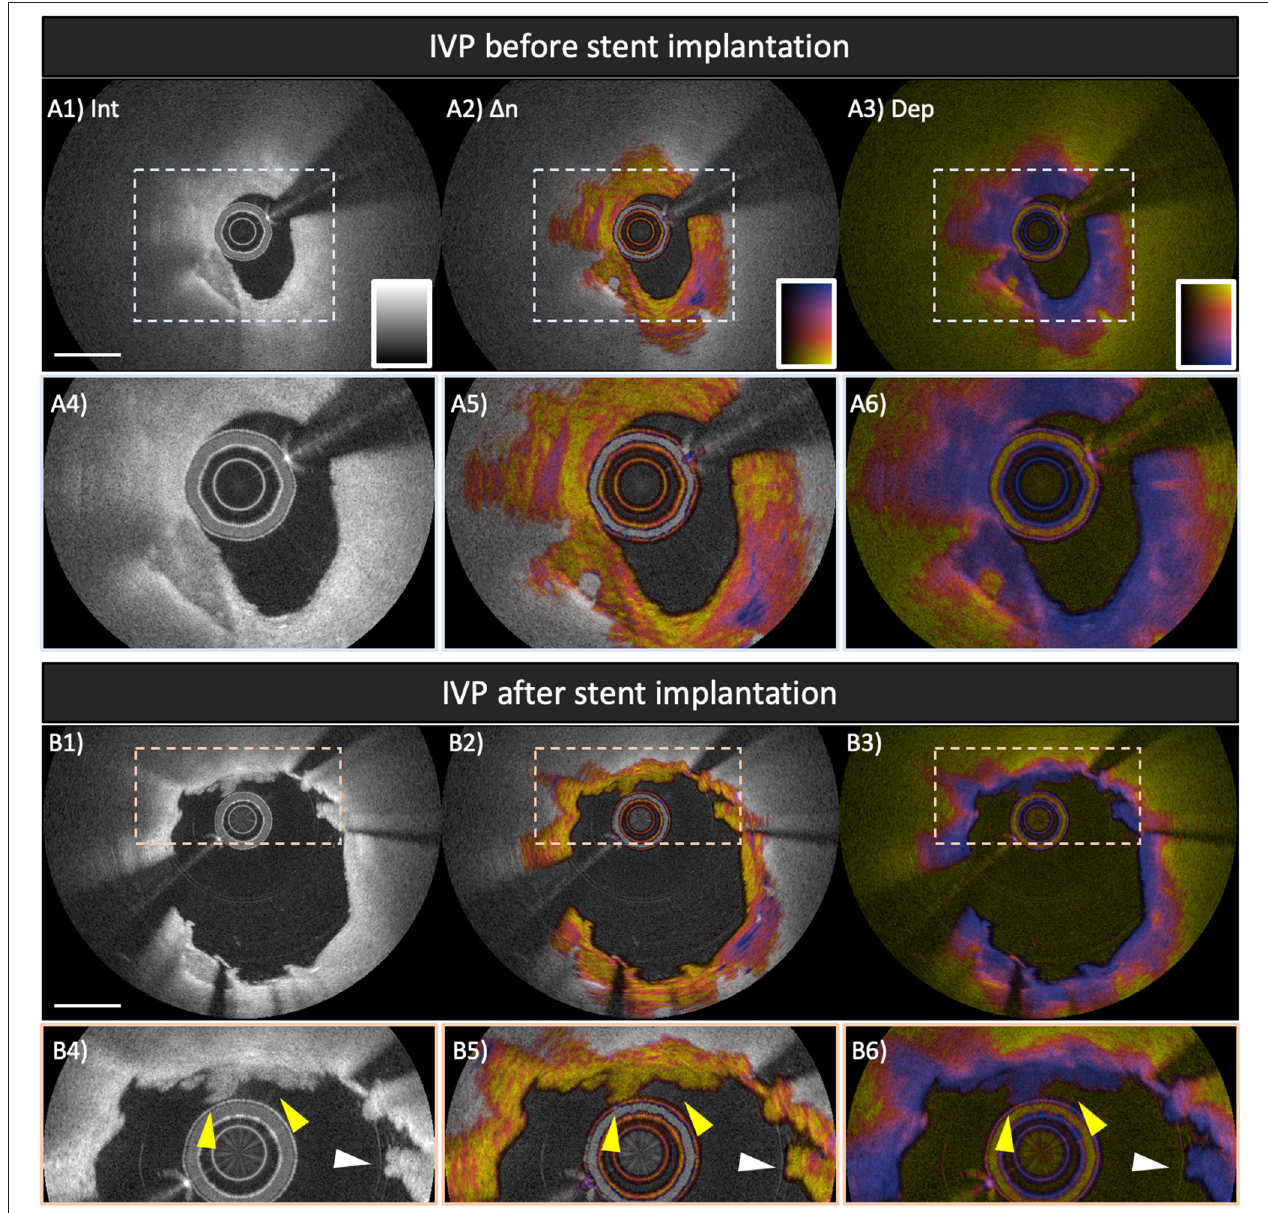
FIGURE 6 | Polarization features pre- and post-stent implantation in the culprit lesion of a patient with non-ST-elevation myocardial infarction. Broken lines in (A1–A3) and (B1–B3) indicate magnified views shown in (A4–A6) and (B4–B6) , respectively. (A1,A4) IVP of the culprit lesion showing a lipid-rich plaque with calcification at 7 o’clock (A2, A5) Birefringence image reveals highly birefringent tissues from 3 to 6 o’clock within the fibrous cap, suggesting well-organized fibrous tissues. (B1–B6) Post-stent IVP of the culprit lesion. (B1,B4) The reflection intensity images visualize tissue protrusion or prolapse (white arrowhead) and in-stent thrombus formation (yellow arrowheads). IVP clearly reveals in-stent thrombus showing low birefringence and low depolarization, which is the typical IVP appearance of white thrombus (B2,B5) . Scale bars indicate 1mm. IVP, intravascular polarimetry.